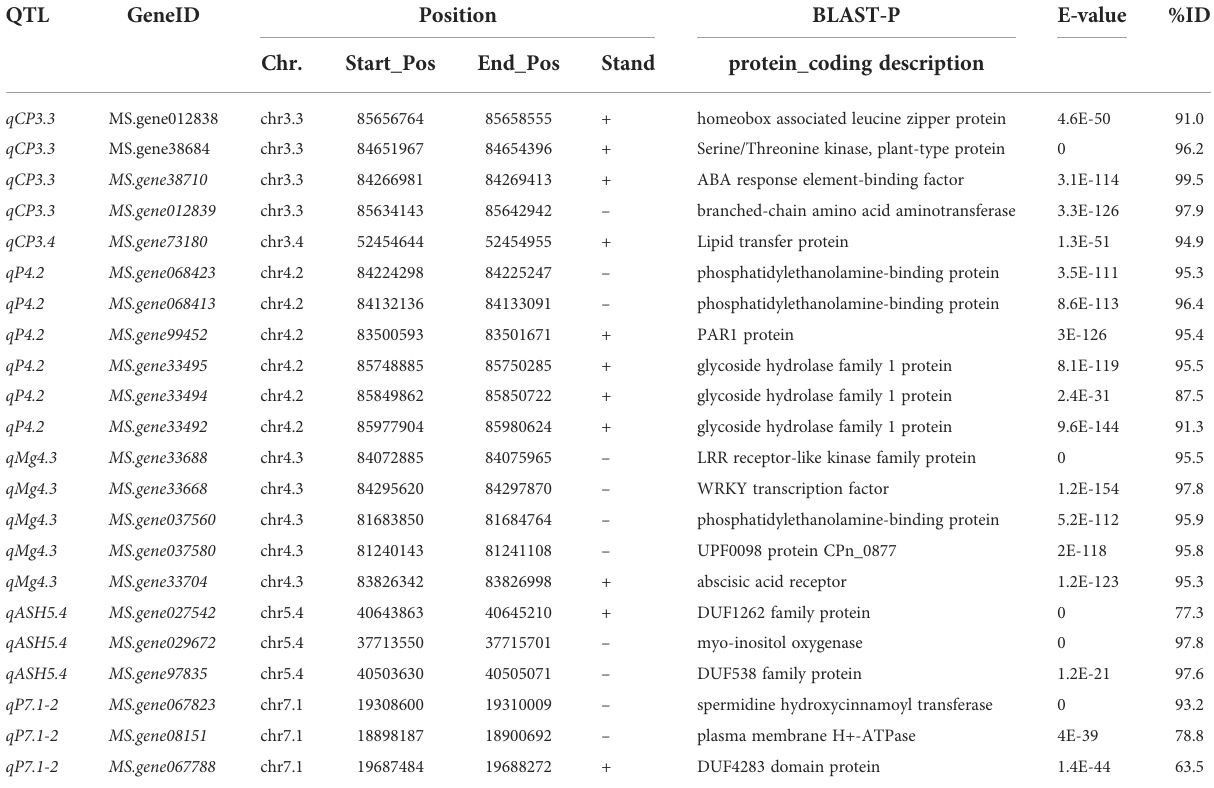
TABLE 3 Potential candidate genes identi fi ed in this